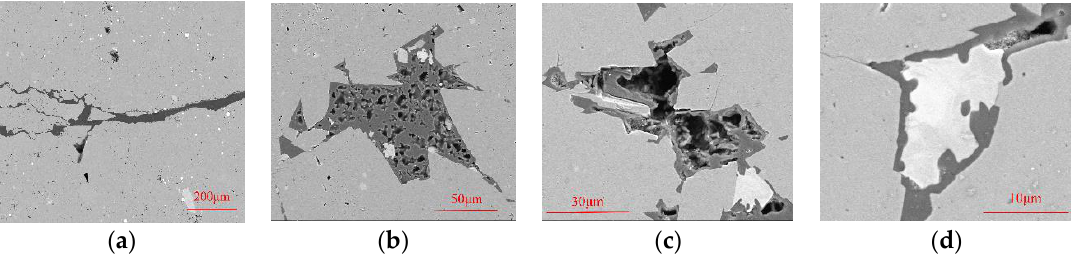
Figure 8. Microscopic distribution characteristics of solid bitumen (SB): ( a ) Gaoshi-7 well, 4834.90 m, SB-filled fracture; ( b ) Moxi-56 well, 4954.54 m, SB-filled pore; ( c ) Moxi-56 well, 4959.91 m, SB-filled edge; ( d ) Moxi-56 well, 4959.91 m, SB-filled surface.